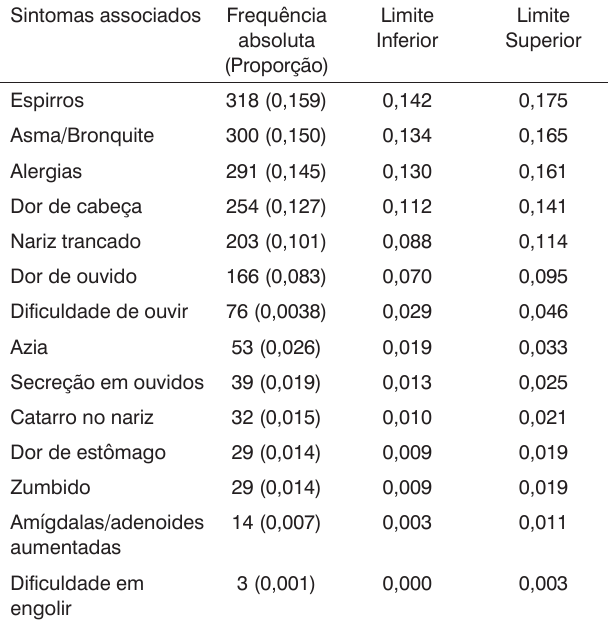
Tabela 4. Limite de confiança dos sintomas associados apre- sentados pelos